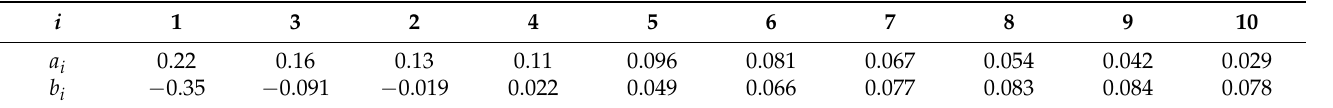
Figure 9. Skewness and Kurtosis of the pressure records at different layers: ( a , b ) CWF1-0°; ( c , d ) TWF30-0°; and ( e , f ) TWF30-30°. Table 1. Coefficients a i and b i for the Cook-Mayne